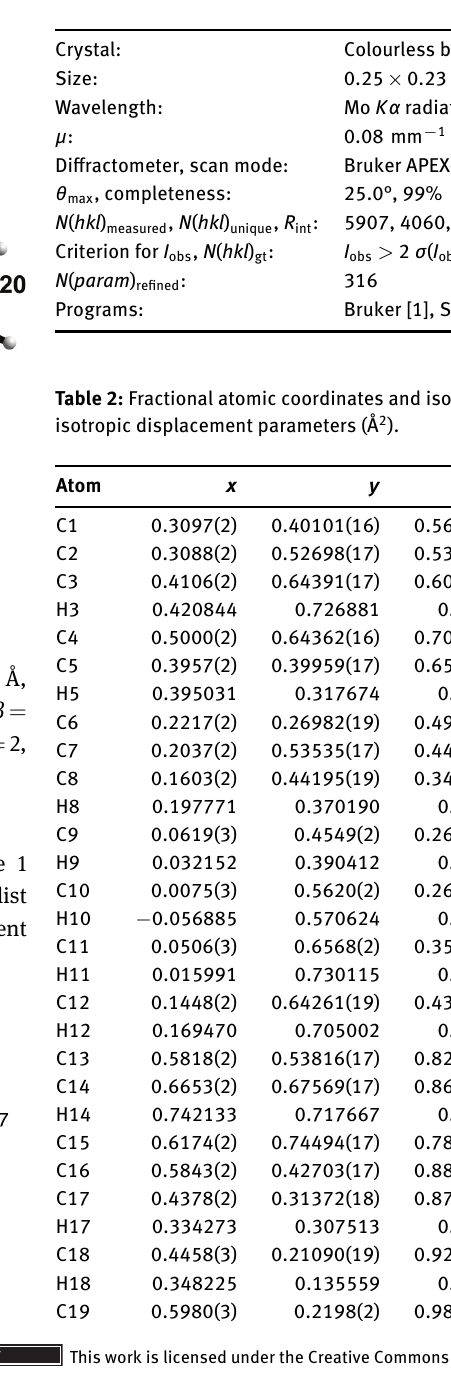
Table 1: Data collection and handling.